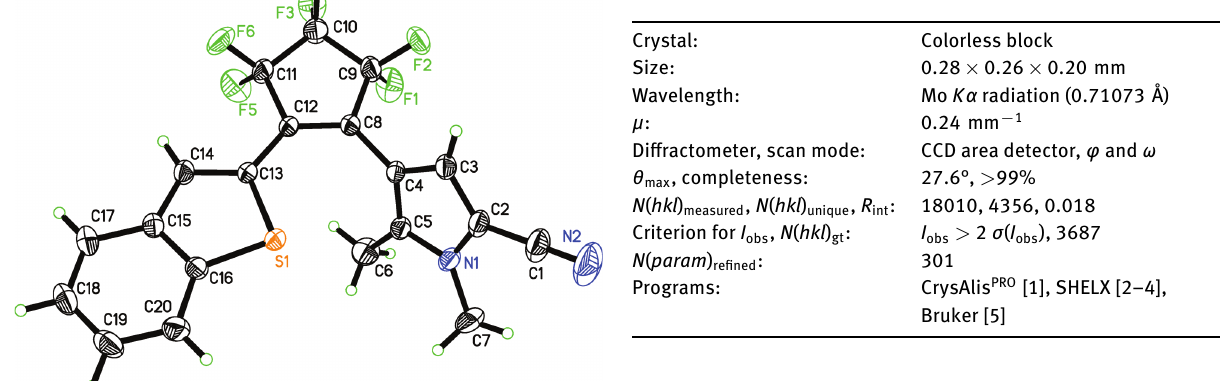
Table 1: Data collection and handling.